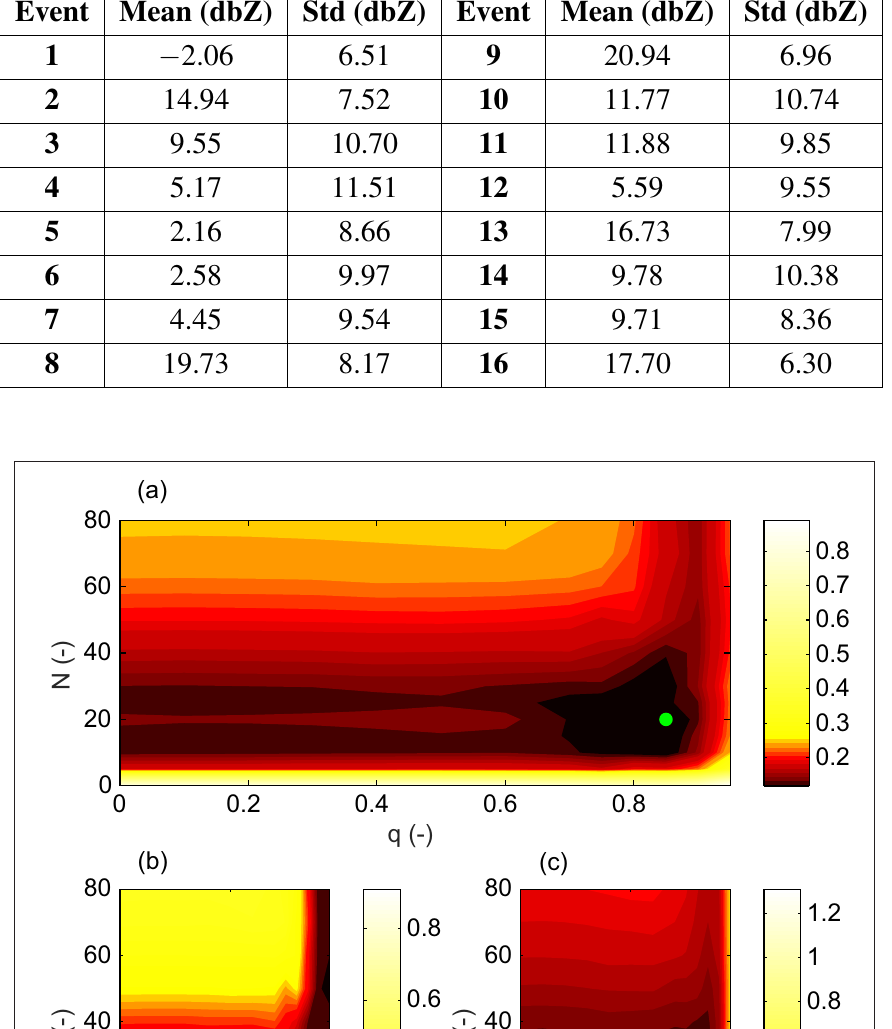
Table 3. Mean and standard deviation (Std) of the threshold values for the analysed events.